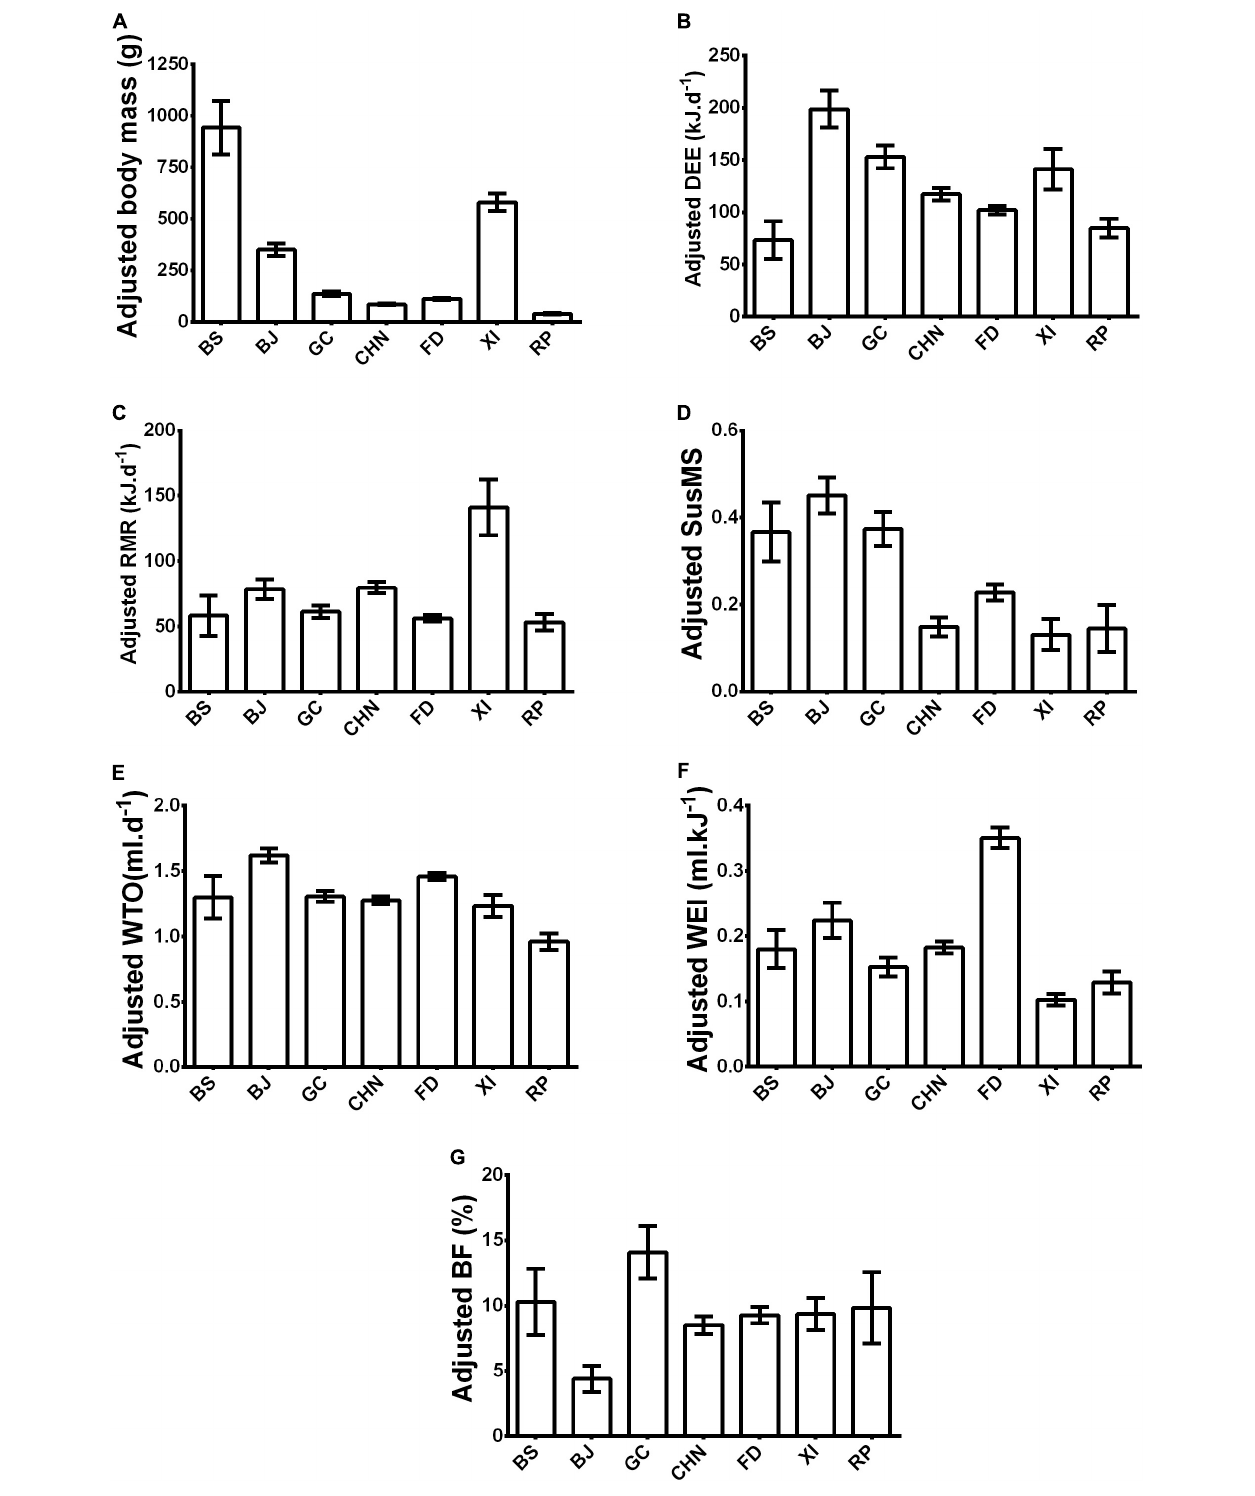
FIGURE 3 | (A) Body mass (g), (B) daily energy expenditure (DEE- kJ.d – 1 ), (C) resting metabolic rate (RMR- kJ.d – 1 ), (D) sustained metabolic scope (SusMS), (E) water turnover (WTO- ml.d – 1 ), (F) water economy index (WEI- ml.kJ – 1 ), and (G) body fat percent (BF- %) of all seven species of rodent featured in this study. BS - Bathyergus suillus; BJ: Bathyergus janetta ; GC - Georychus capensis ; CHN - Cryptomys hottentotus natalensis ; FD - Fukomys damarensis ; XI - Xerus inauris ; RP - Rhabdomys pumilio . Data are shown as adjusted mean(EMMs) ± SE.